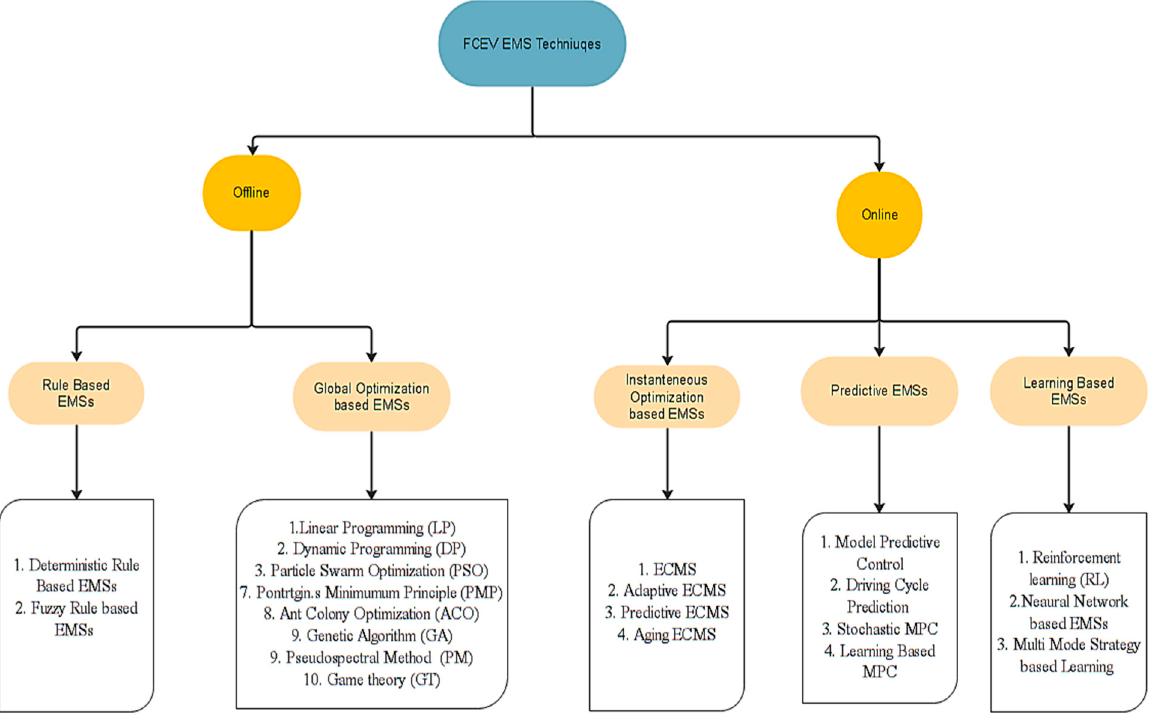
Figure 7. Categorization of EMS techniques.